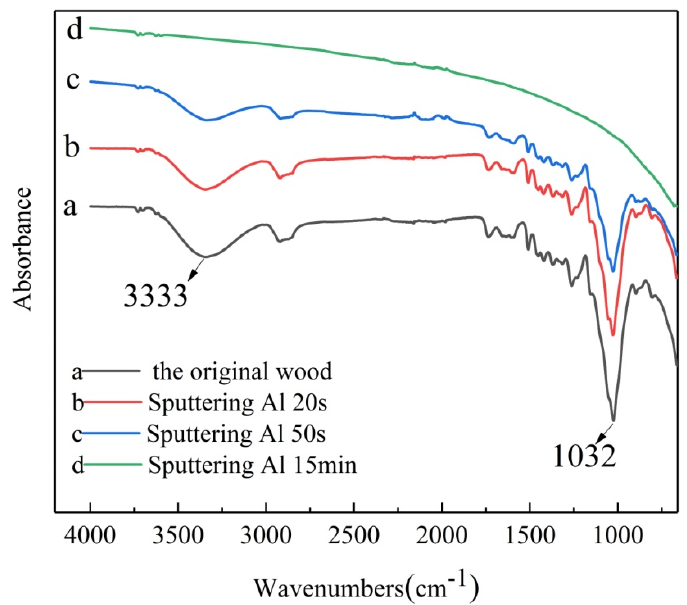
Figure 8. Infrared spectrum (FTIR) of nano-Al metallized wood.